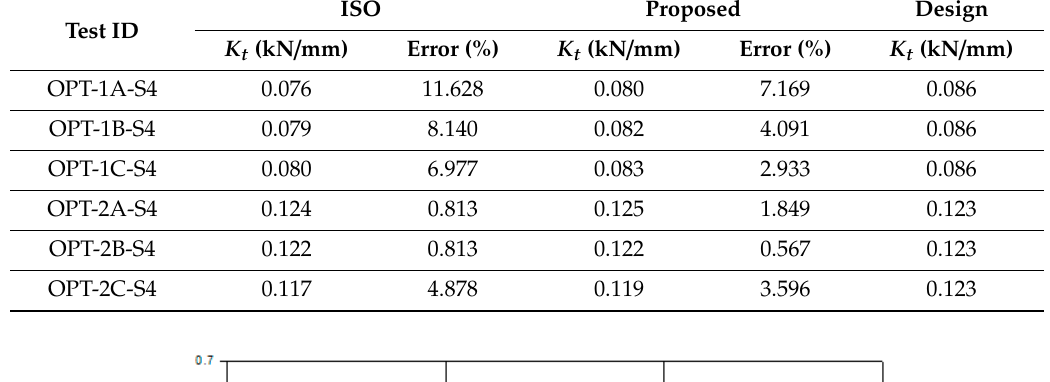
Figure 13. Test results for design shear deformation range (±35 mm): ( a ) OPT-1; ( b ) OPT-2.